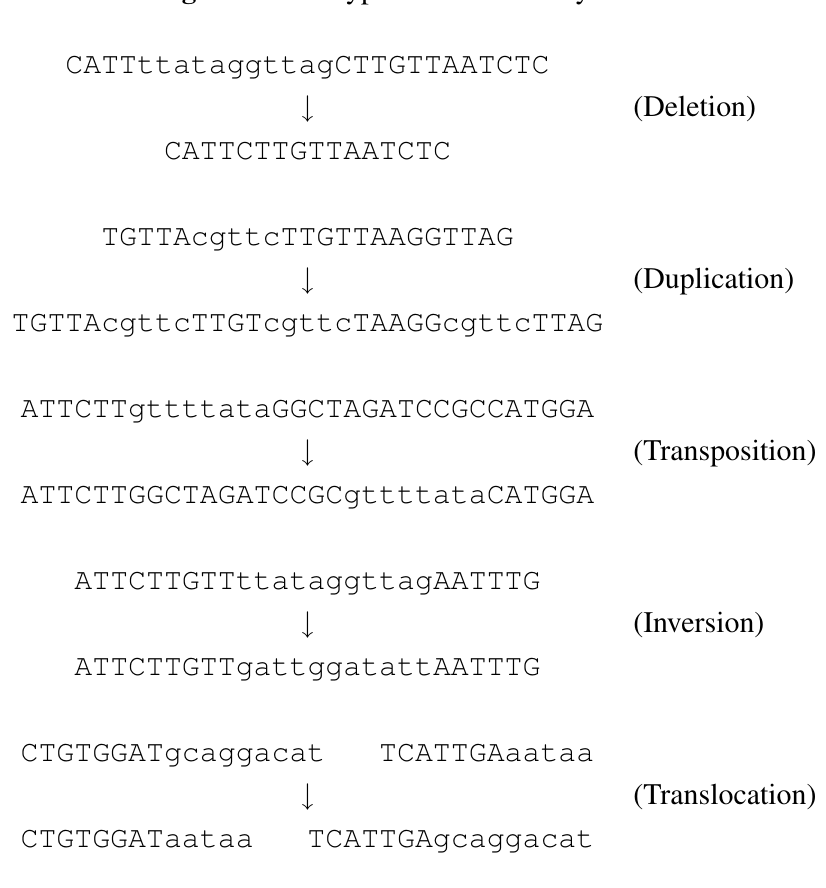
Figure 4. Five types of evolutionary